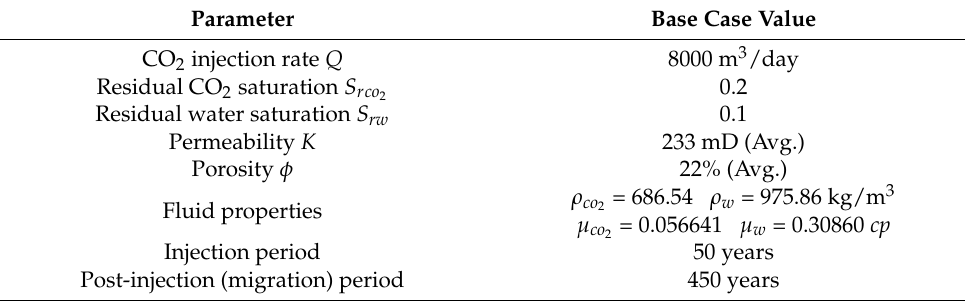
Table 1. The simulation parameters and corresponding values for the base